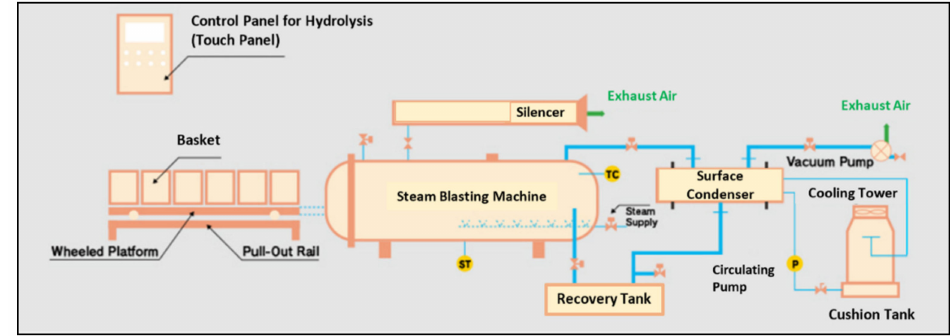
Figure 1. The structural flowchart of the steam explosion equipment/reactor used in this study (from Yasujima Co., Ltd.).